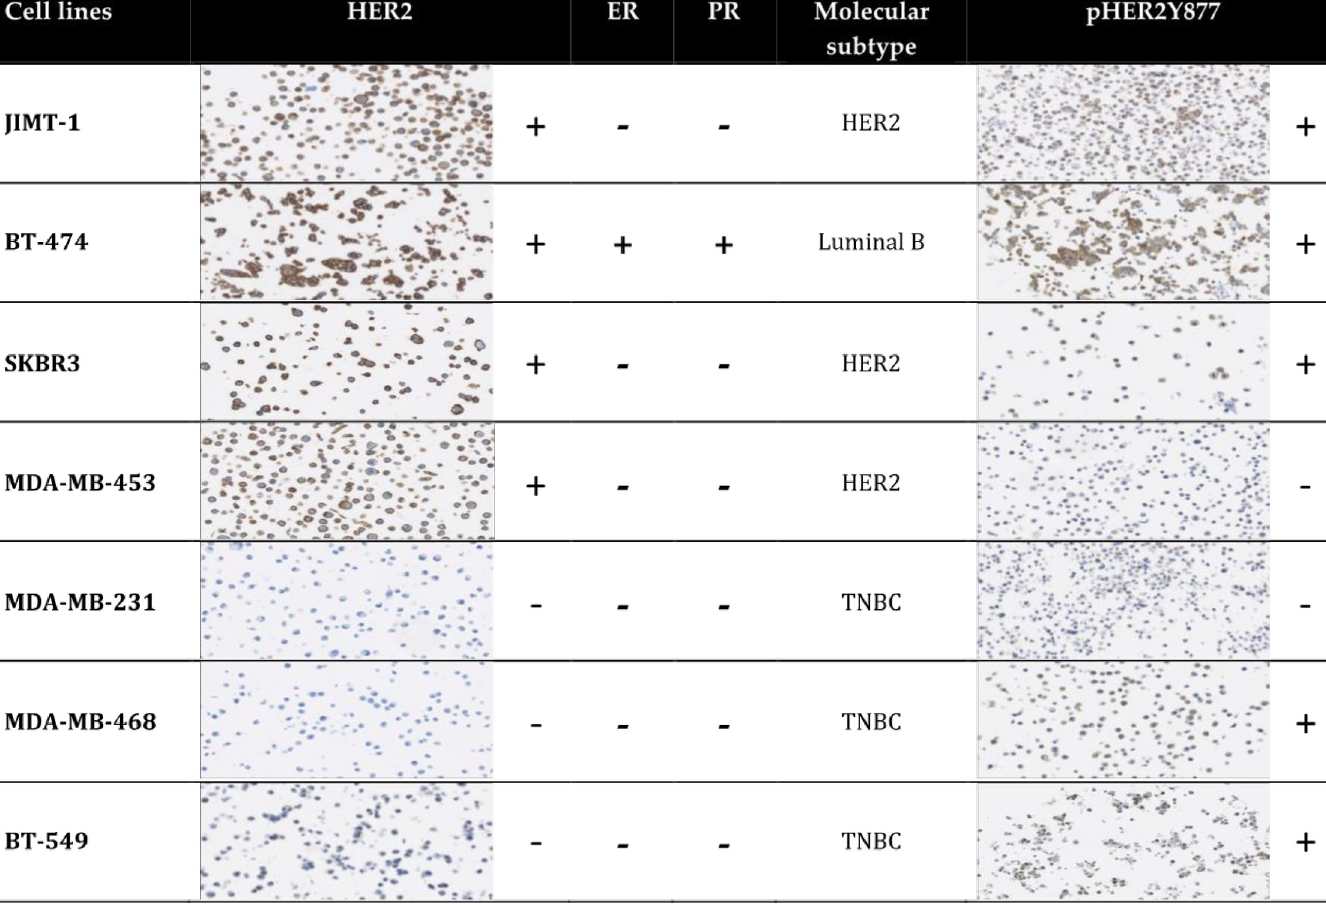
Fig 4. Brest cancer cell lines description. Breast cancer cell lines selected depending on their HER2 and pHER2 Y877 status. HER2 status was obtained by using the Herceptest TM kit–Dako and pHER2 Y877 was using by IHC with a specific anti-pHER2 Y877 antibody. ER (Estrogen Receptor) and PR (Progesterone Receptor) were confirmed by literature. HER2 (Human Epidermal Receptor 2), ER (Estrogen Receptor), PR (Progesteron Receptor), TNBC (Triple Negatif Breast Cancer).